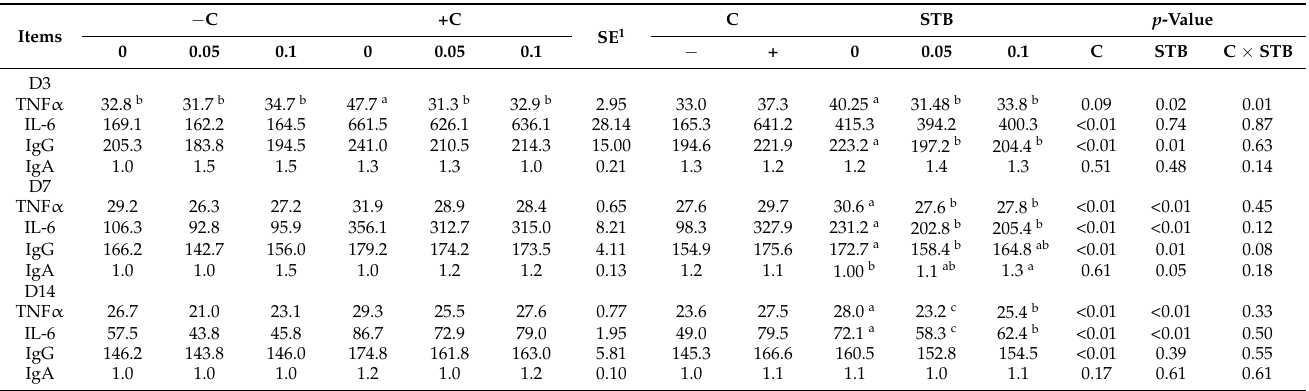
Table 6. Effects of stimbiotic supplementation on the proinflammatory cytokines of pigs challenged with